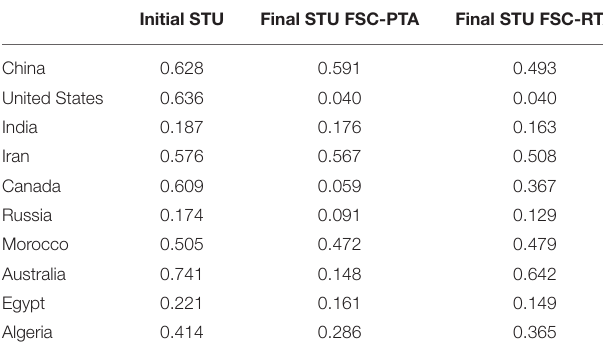
TABLE 3 | Stocks to use in highest reserves countries.